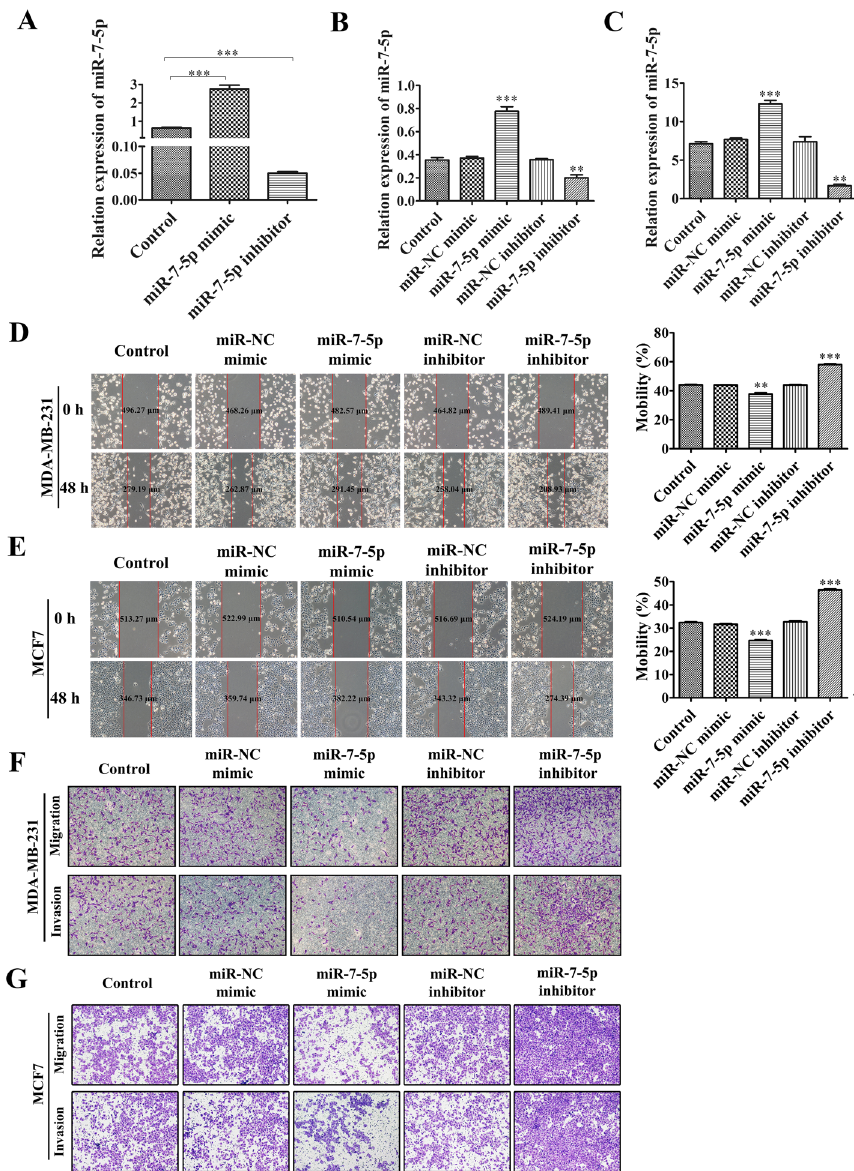
Fig. 3 Downregulation of exosomal miR-7-5p expression significantly facilitates the migration and invasion of breast cancer cells. A Expression of miR-7-5p in the secreted exosomes of blank control, miR-7-5p mimic and suppressor transfected MDA-MB-231 cells was measured using qRT-PCR assay. B , C The expression of miR-7-5p in MDA-MB-231 cells and MCF7 cells after transfection of blank control, miR-7-5p mimics and inhibitors and their negative controls was measured using qRT-PCR assay. D , E Wound healing assay using blank control, miR-7-5p mimic and inhibitor and its negative control after treatment of MDA-MB-231 cells and MCF7 cells. F , G The migratory invasion ability of cells after treatment of MDA-MB-231 cells and MCF7 cells with blank control, miR-7-5p mimics and inhibitors and their negative control was examined using Transwell assay. Data are presented as mean SD ( n 3). * p < 0.05, ** p < 0.01, *** p < ± =